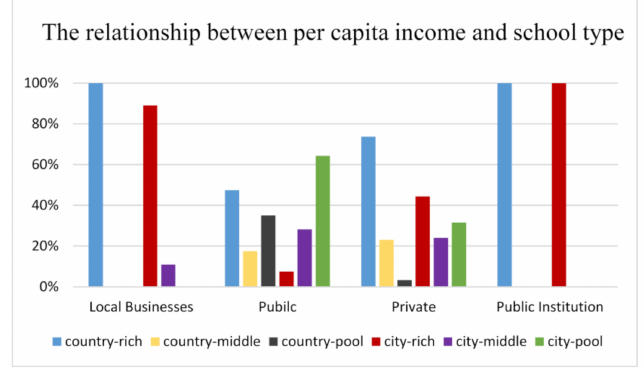
Figure 13. The relationship between per capita income and school